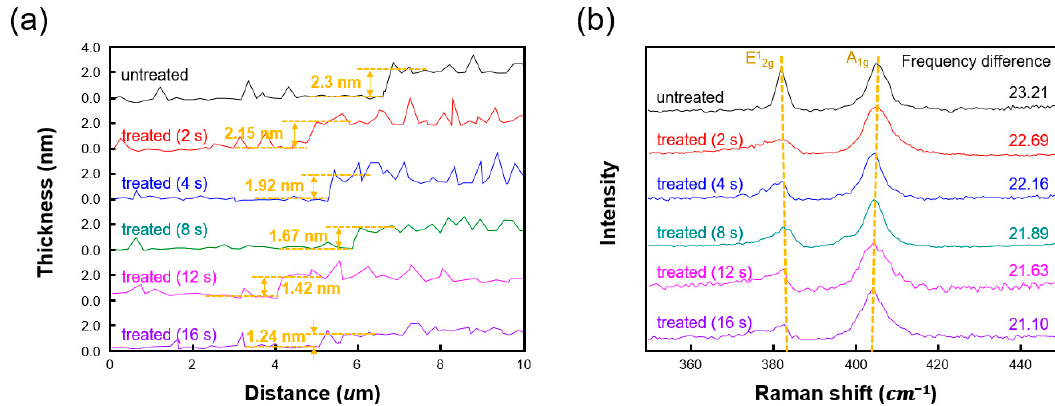
Figure 3. ( a ) Thickness and ( b ) Raman spectra of MoS 2 films that were plasma treated for different durations. The frequency difference between Raman shifts indicates that the etching of the MoS 2 film depended on the treatment time. In addition, the AFM results indicate that the sulfur vacancies were generated in 2 s.